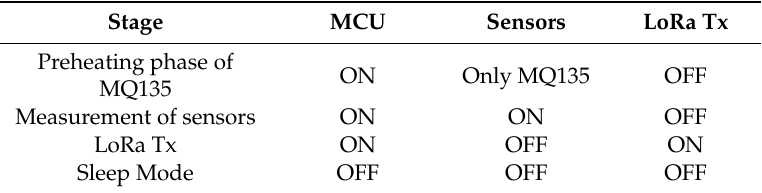
Table 3. Stages of modules in each state.